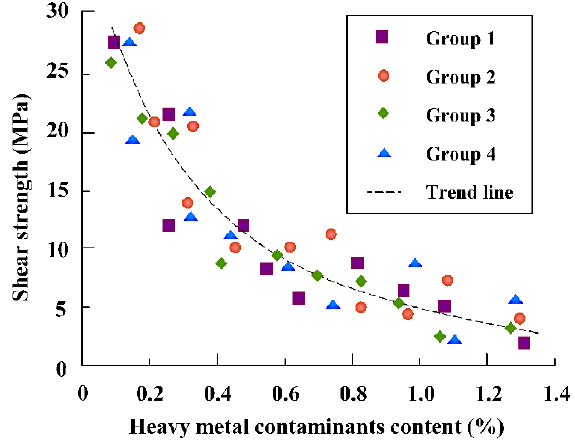
Fig. 1. The relationship between shear strength and heavy metal content